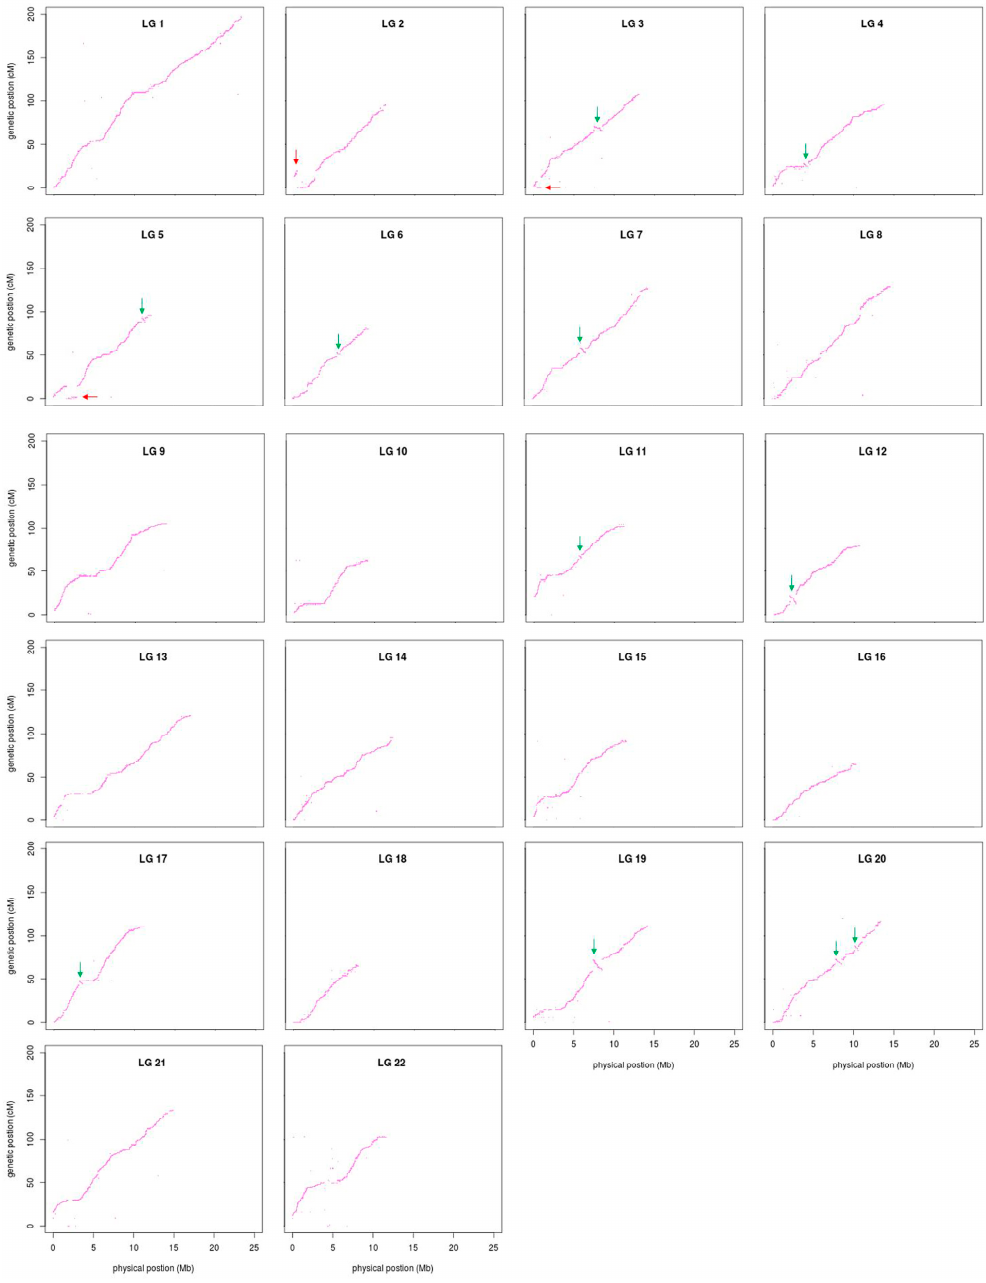
Figure 6. Concordance of SNP positions on the present genetic linkage map with those on FUGU5. The x-axis represents the physical position (Mb) of SNPs on FUGU5, whereas the y-axis represents the genetic position (cM) of SNPs on the linkage map. Red arrows indicate potentially misplaced or segmentally polymorphic regions, whereas green arrows indicate potentially mis-oriented or segmentally polymorphic regions in FUGU5.